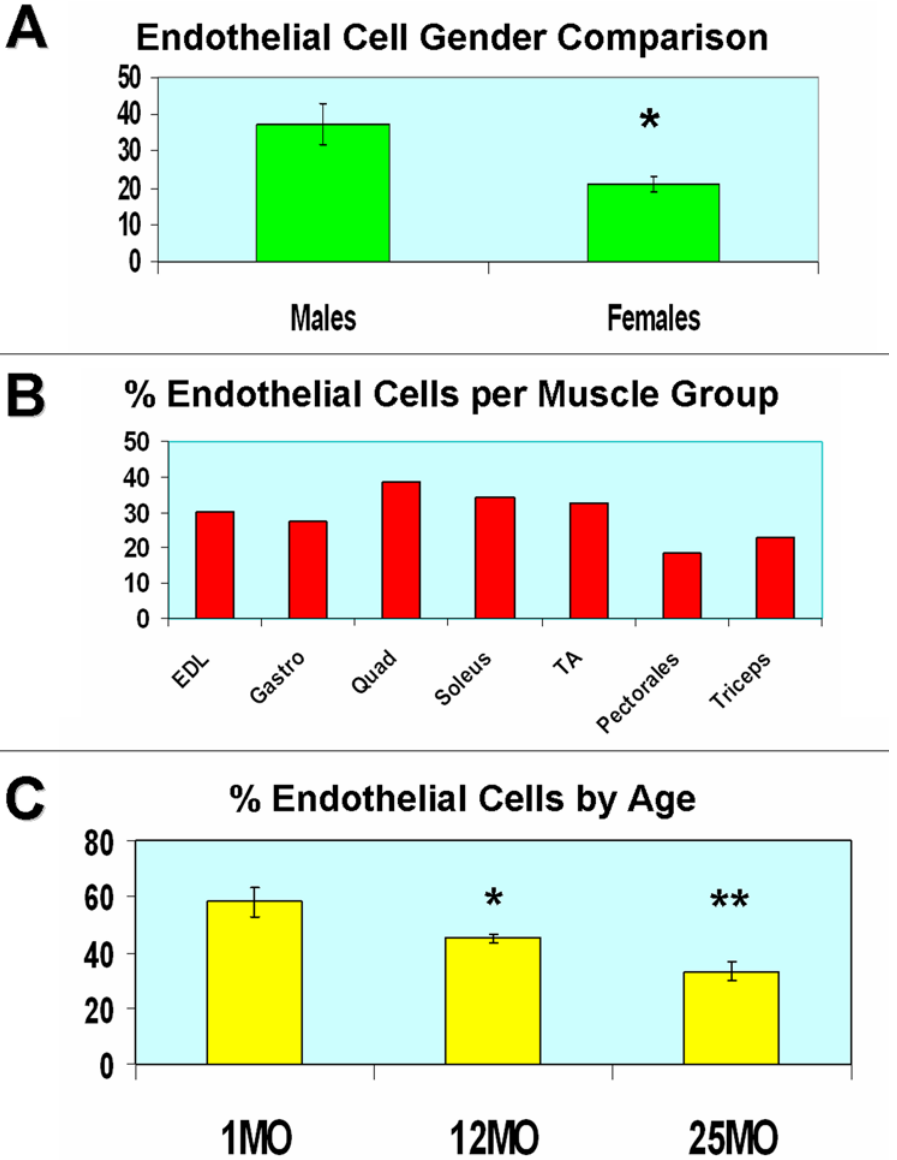
Figure 3. Muscle EC abundance between gender, muscle goups and age. A, Gender comparison of the percentage (y-axis) of EC within the CD45 2 population between 2 MO mice (n=3). * designates p , 0.05. B, The percentage of EC within the CD45 2 population among different skeletal muscles. C, Age comparison of the percentage of EC within the CD45 2 population between 1, 12 and 24 MO mice (n=3). * designates p , 0.05 between 1 vs. 12 MO mice. ** designates p , 0.05 between 12 vs. 25 MO mice. P values calculated by student